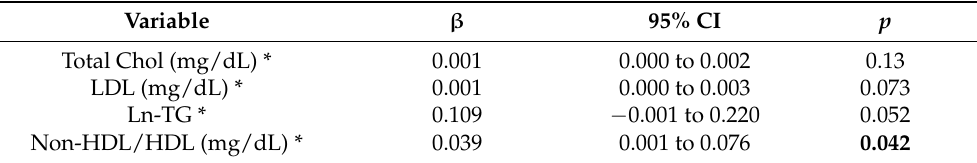
Table 2. Relationship between lipid parameters and carotid